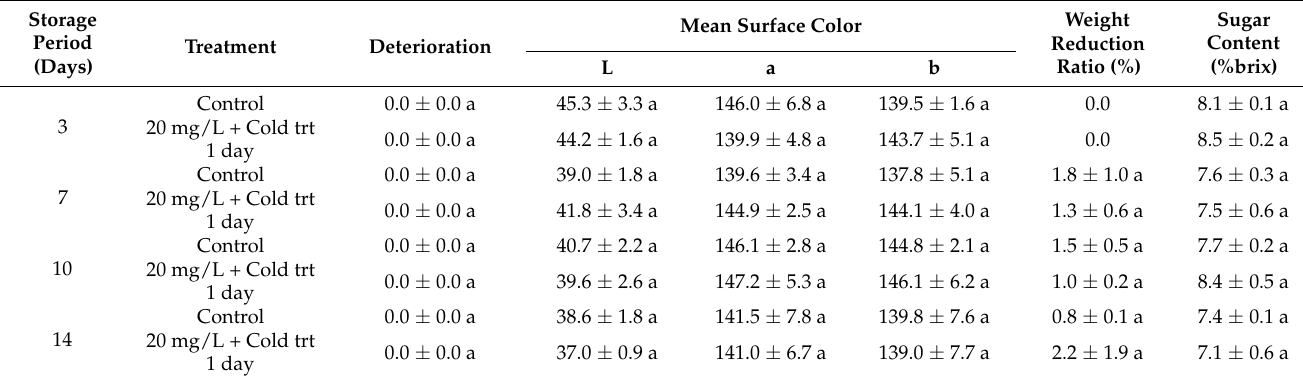
Table 7. Phytotoxicity on strawberry (‘ Maehyang ’ cultivar) exposed to 20 mg/L methyl bromide for 3 h (Ct product = 41.7 mg h/L) at 18 ◦ C and cold treatment for 1 day at 0 ◦ C in 500 L container, then stored at 5 ± 1 ◦ C. Storage